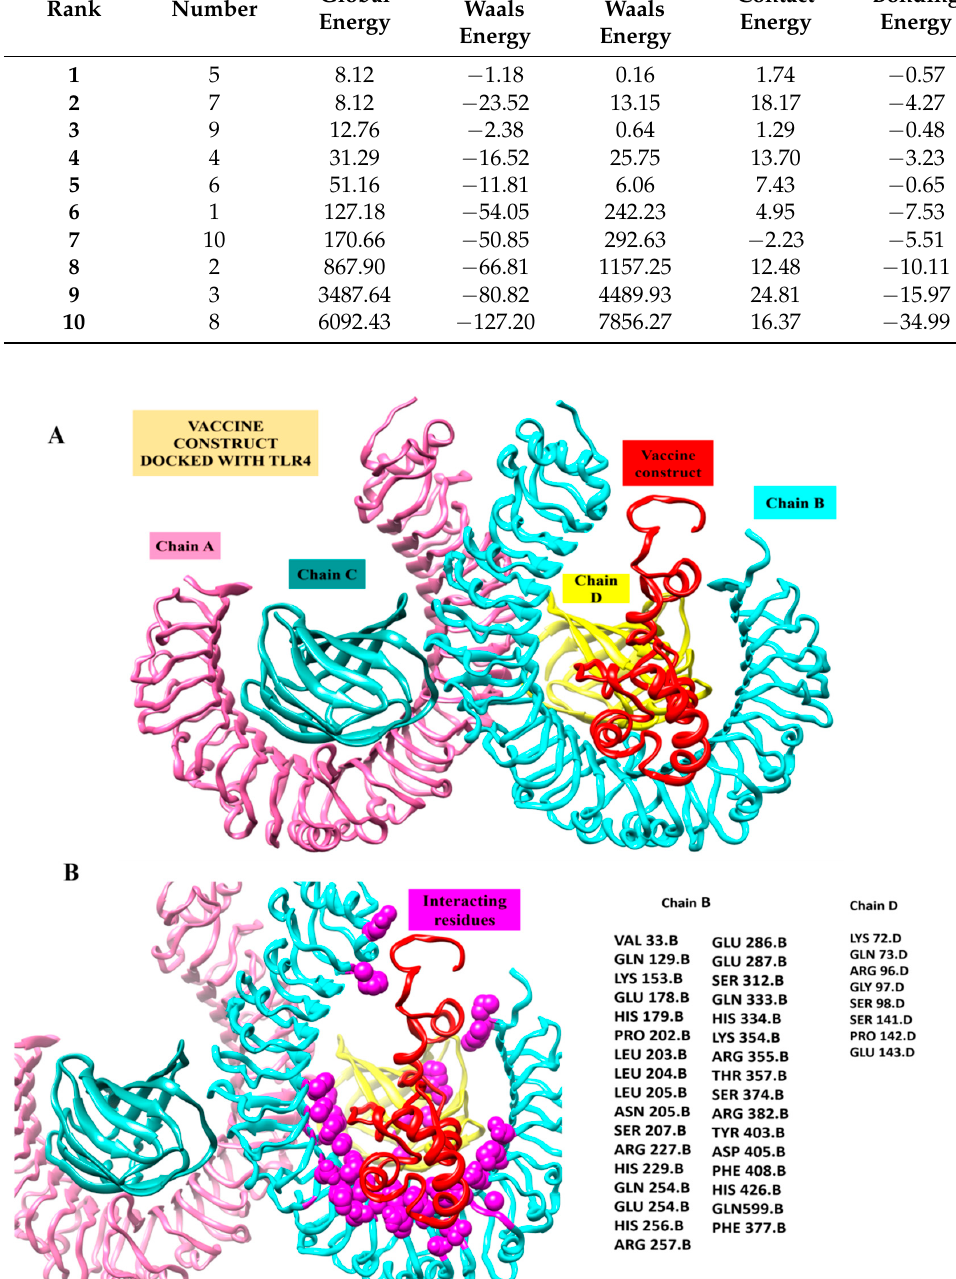
Figure 7. Inspection of a proposed chimeric peptide vaccine construct and the TLR4 complex using molecular docking. ( A ) Vaccine construct’s predicted docked mode in relation to TLR4. The vaccine construct is shown in red using the New-Cartoon drawing approach, while the TLR4 chains are depicted using various colored beads: Chain A (plum) Chain B (cyan) chain C (dark cyan) and Chain D (yellow). ( B ) Vaccine construct’s interactions within five Angstrom region of TLR4 Receptor. Chains B (cyan) and D (Yellow) shows interaction with Vaccine construct. The vaccine design is shown in a red cartoon, while TLR4 chain interaction residues depicted as spheres in magenta color. Table 4. Refined PatchDock complexes as an outcome of FireDock assay.